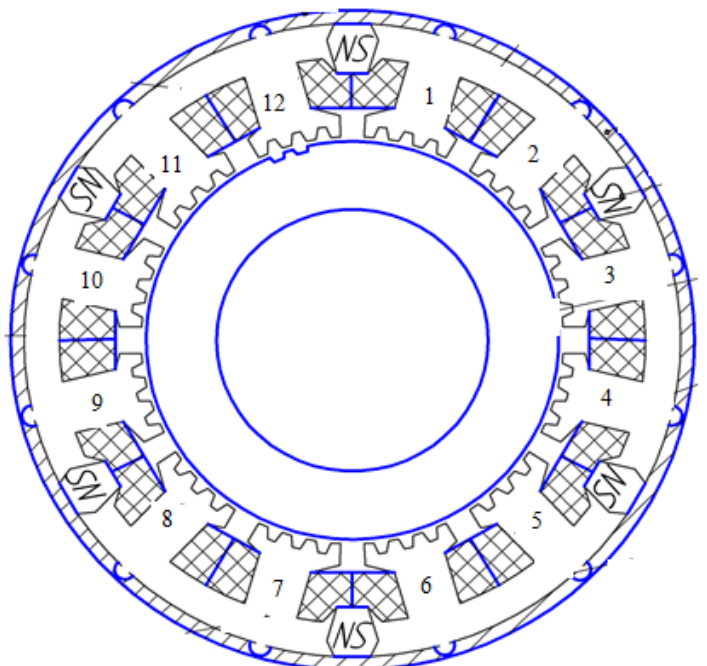
Figure 2. Electric motor design.